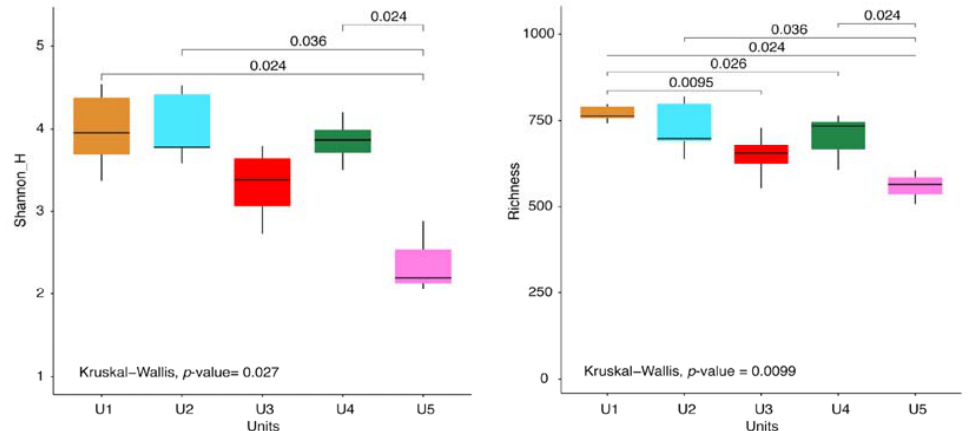
Figure 4. Alpha-diversity indices (Shannon-H left panel, richness right panel) of the five units of the permafrost core of Ad é lie Cove rock glacier (considering filamentous fungi, yeasts, and unclassified taxa). Significant ( p < 0.05) differences are highlighted by connectors.